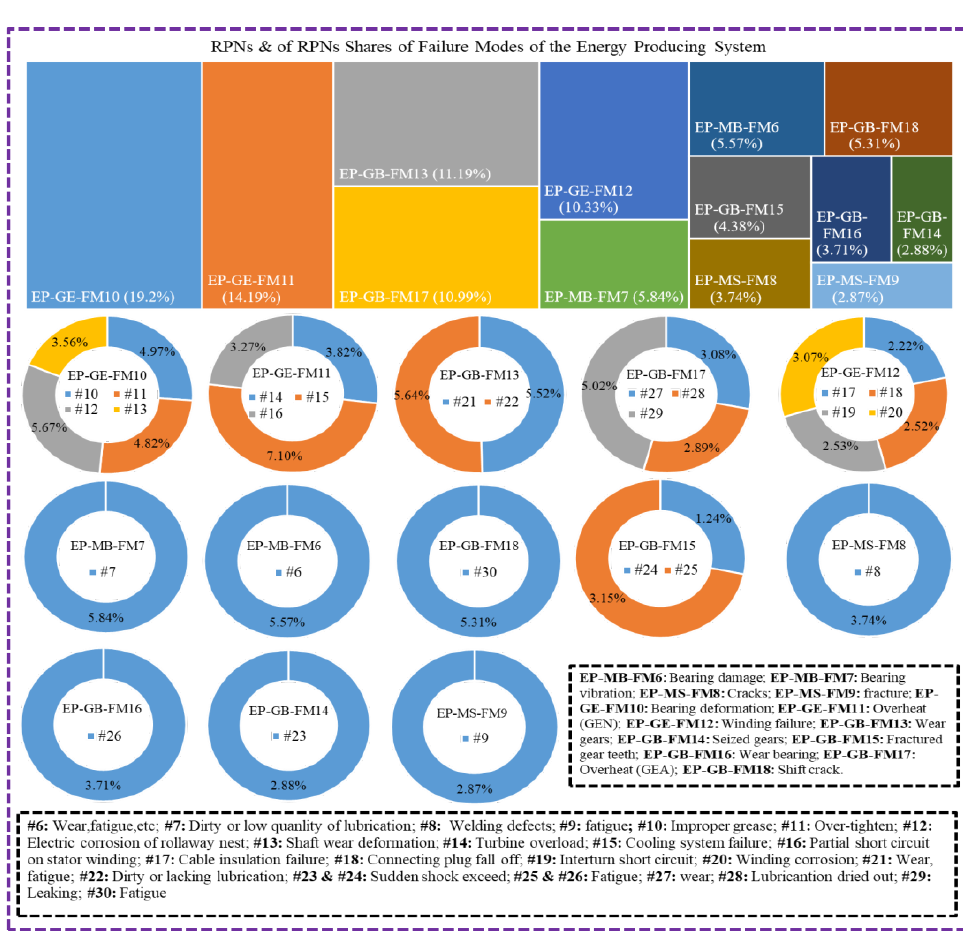
Figure 3. Failure features of the energy-producing system failures/Hierarchical relations among sys- tems, components, failure modes, as well as failure causes are listed in Appendix A; #: Failure cause.